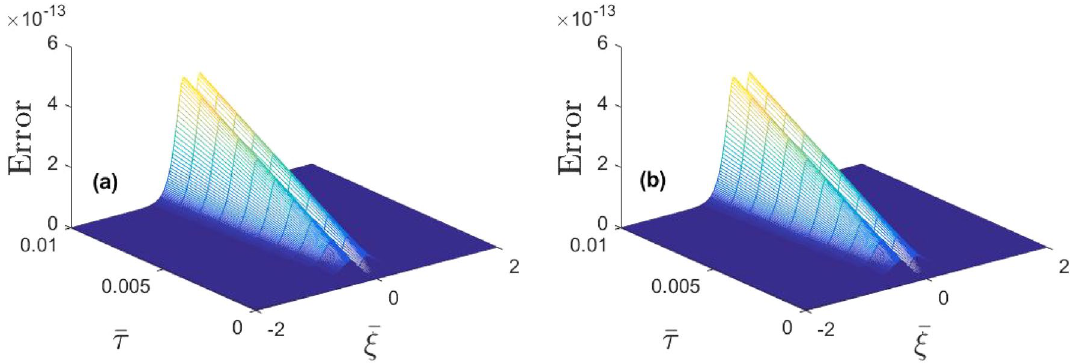
Figure 7. ( a ) 3D error plot for Table 1and ( b ) 3D error plot for Table